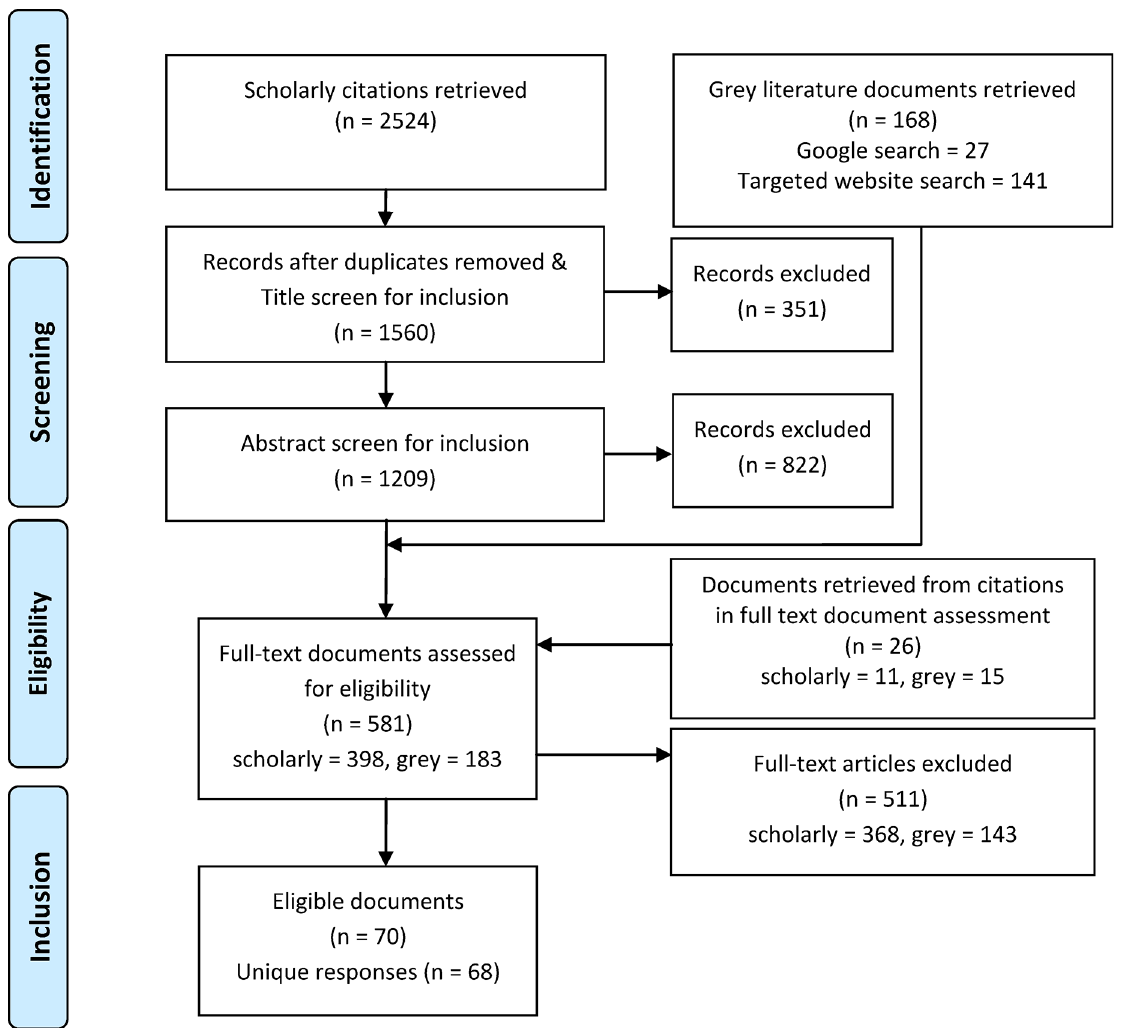
Fig 1. PRISMA Flow Diagram for the Identification of Elder Abuse